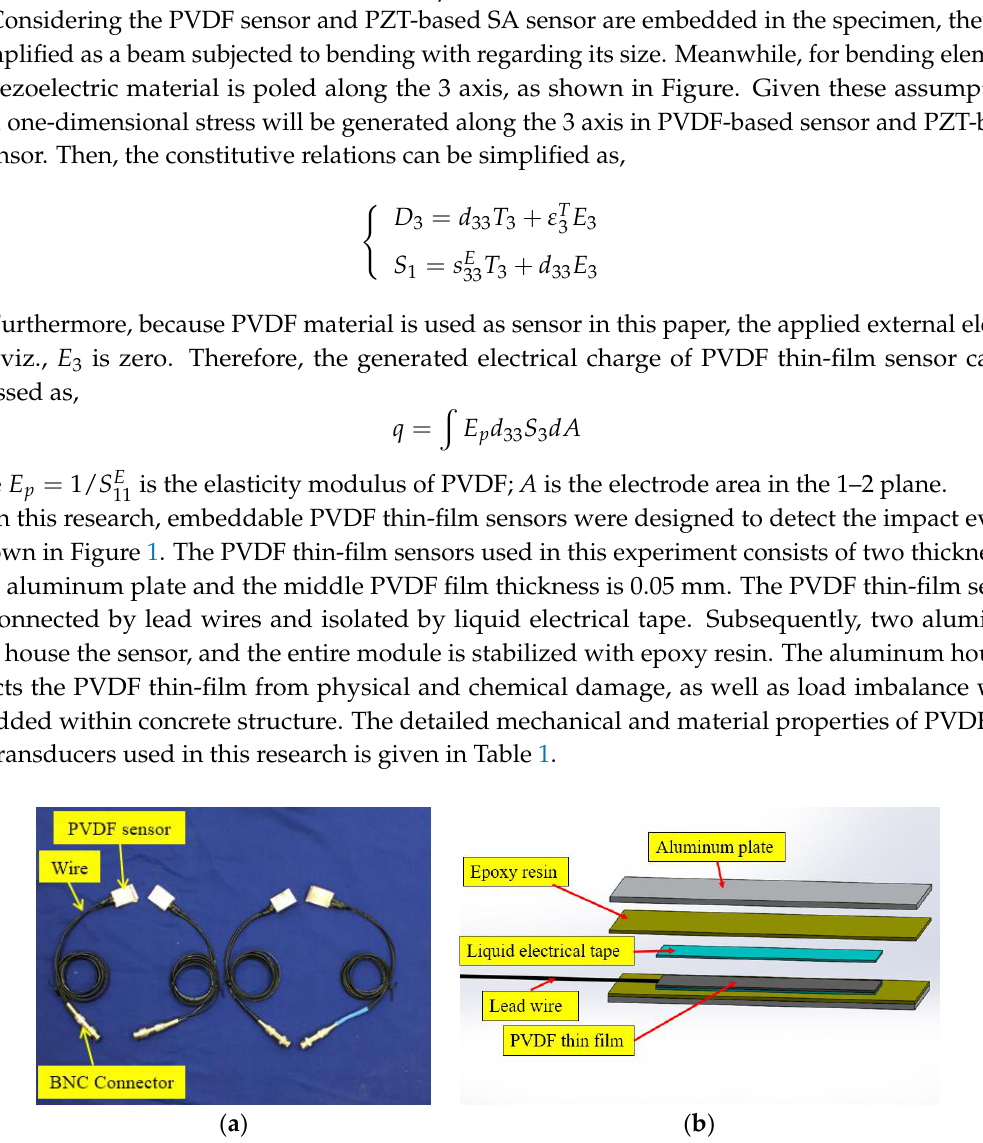
( 6 × 3 ) are the matrices of the piezoelectric strain jk